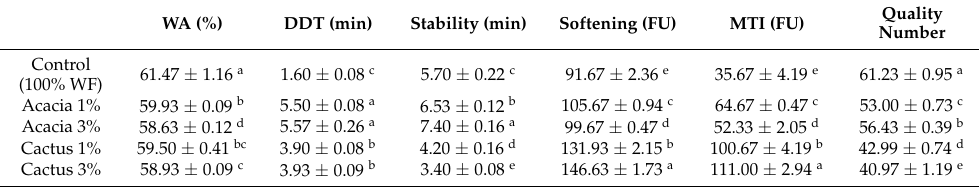
Table 1. Effect of acacia and cactus gums on the dough mixing